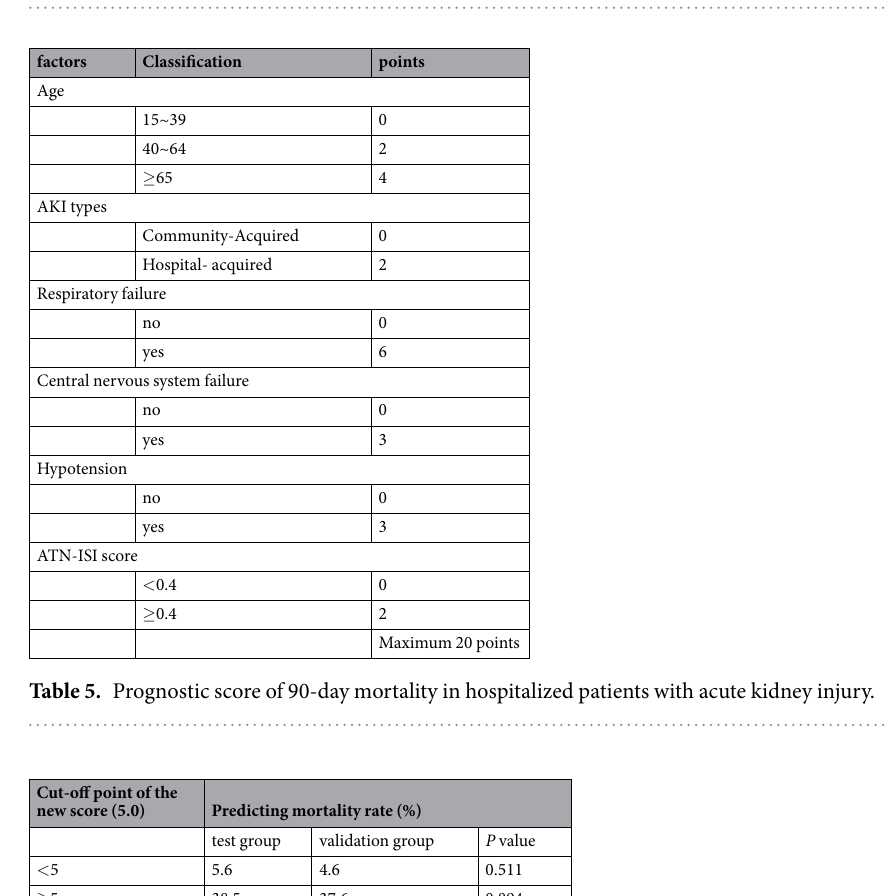
Table 4. Multivariate logistic regression analysis of prognosis within 90 days in patients with acute kidney injury in the test group. Abbreviation: AKI: acute kidney injury; CNS: central nervous system; ATN-ISI: acute tubular necrosis-individual severity index.